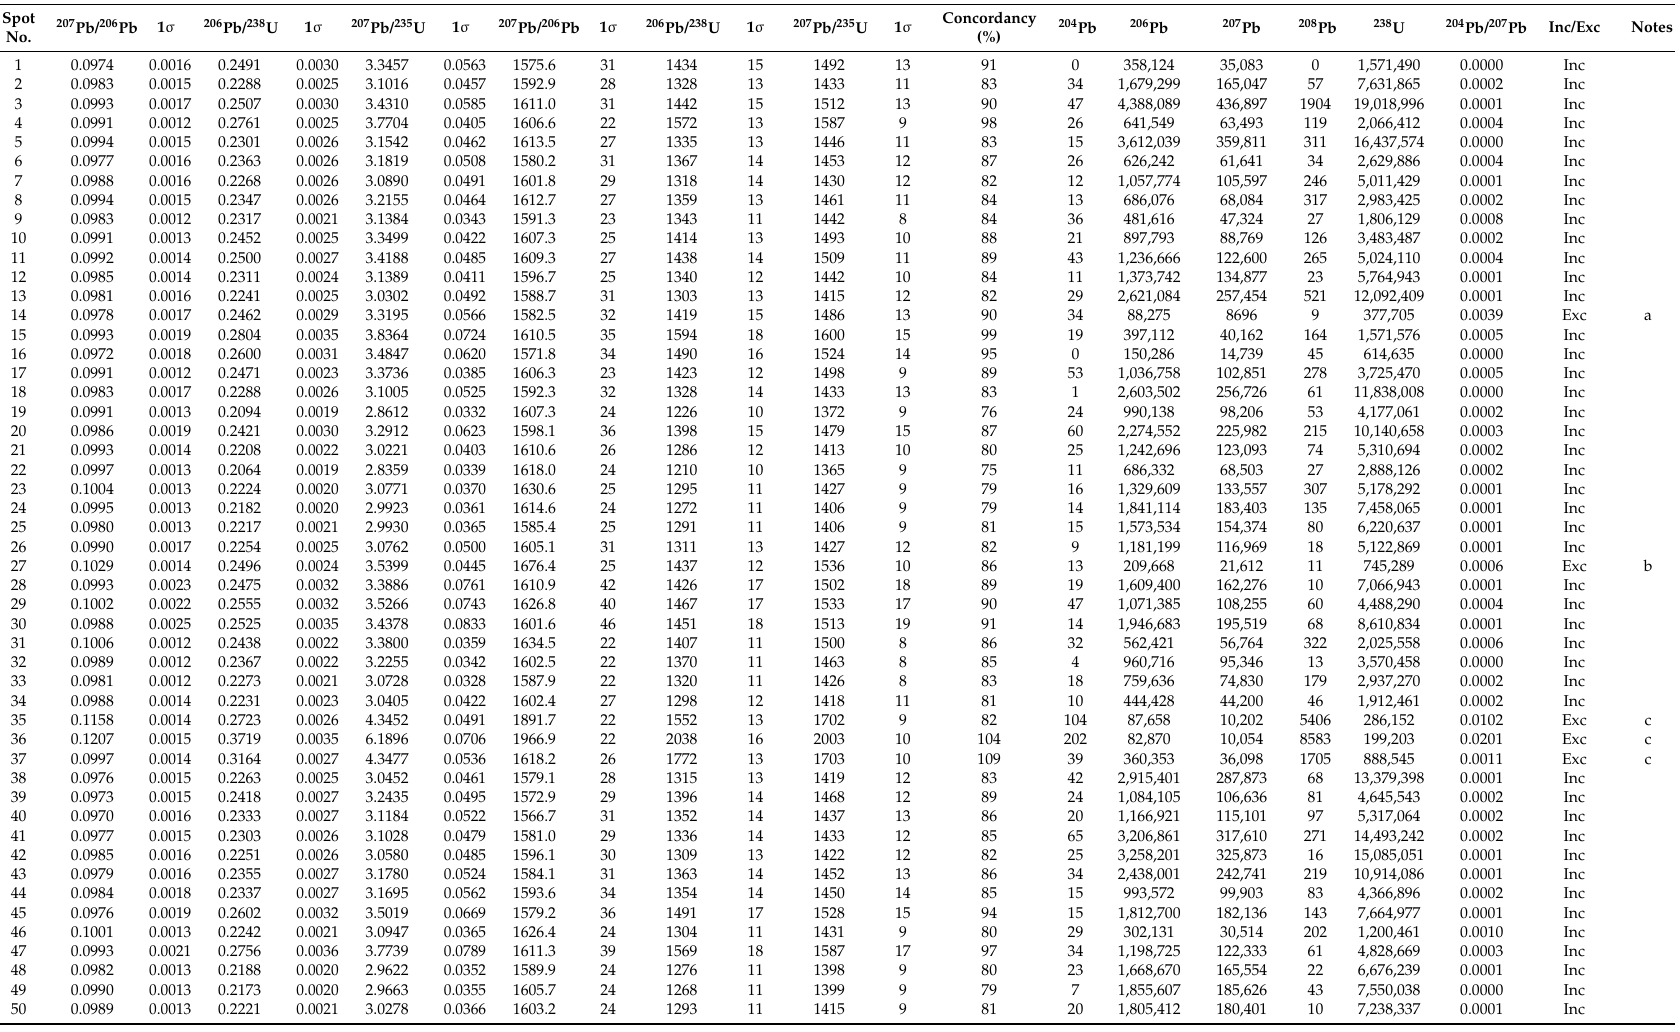
Table 4. Geochronological data for zoned hematite (sample PH-93) using GJ-1 Zircon as standard, U units are in net integrated